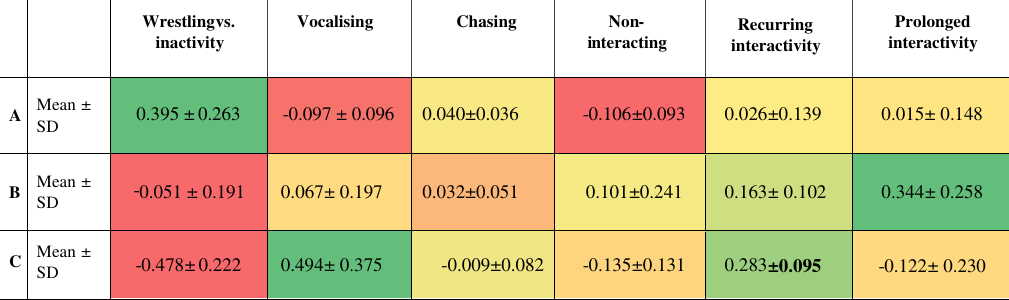
Table 3. Mean factor scores of the clusters evaluated at the higher level. Low standard deviation suggesting importance of the mean score is highlighted in